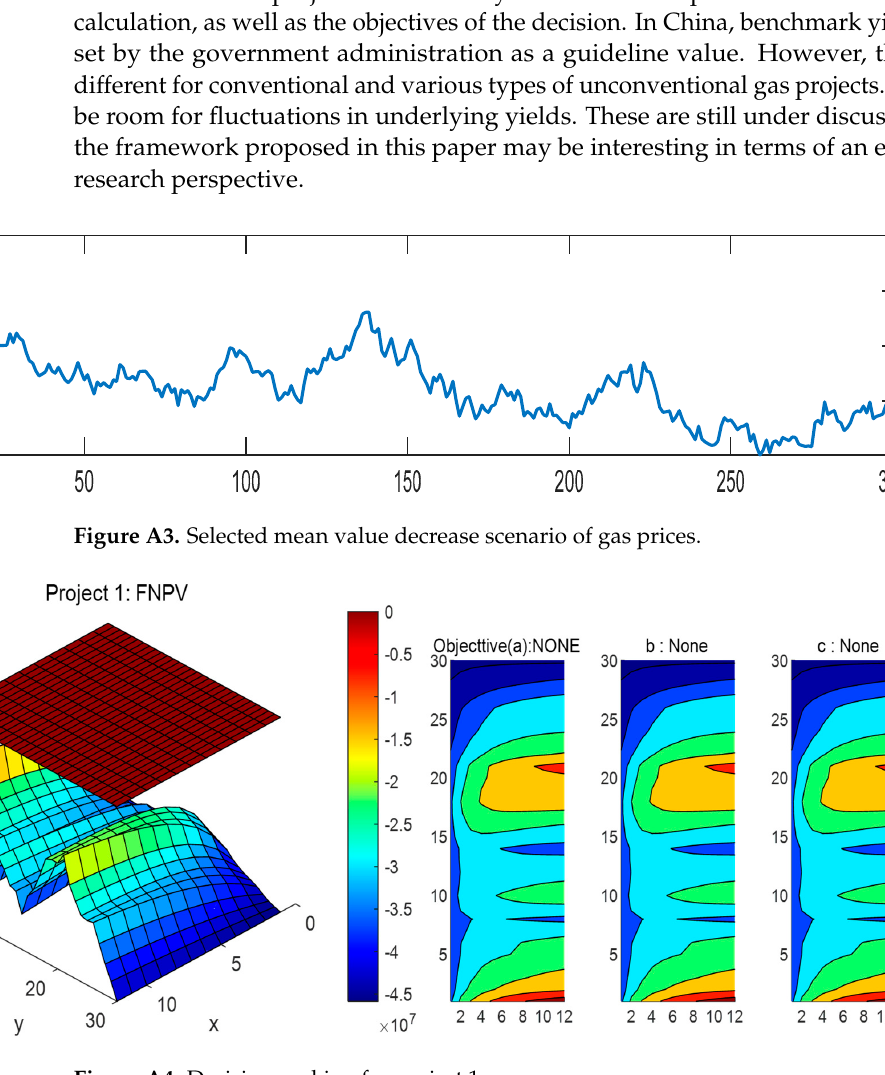
Figure A5. Decision − making for project 2.